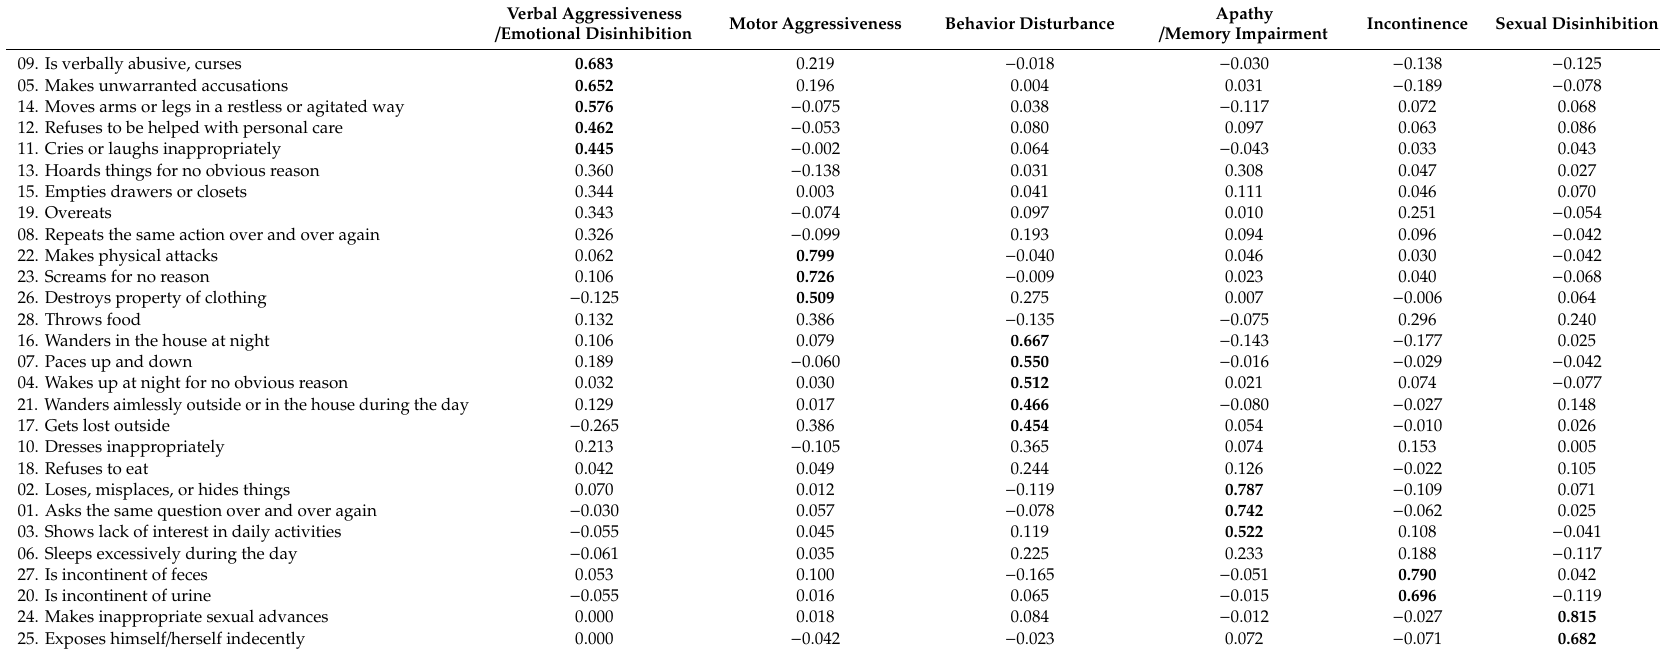
Table 1. Factor analysis of Dementia Behavior Disturbance Scale subitems in subjects with MCI and early-stage AD. Verbal Aggressiveness / Emotional Disinhibition Motor